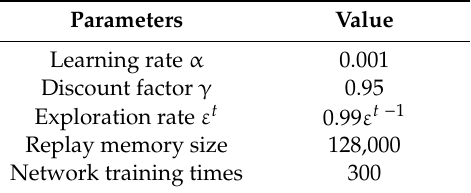
Table 2. DQN training parameters.